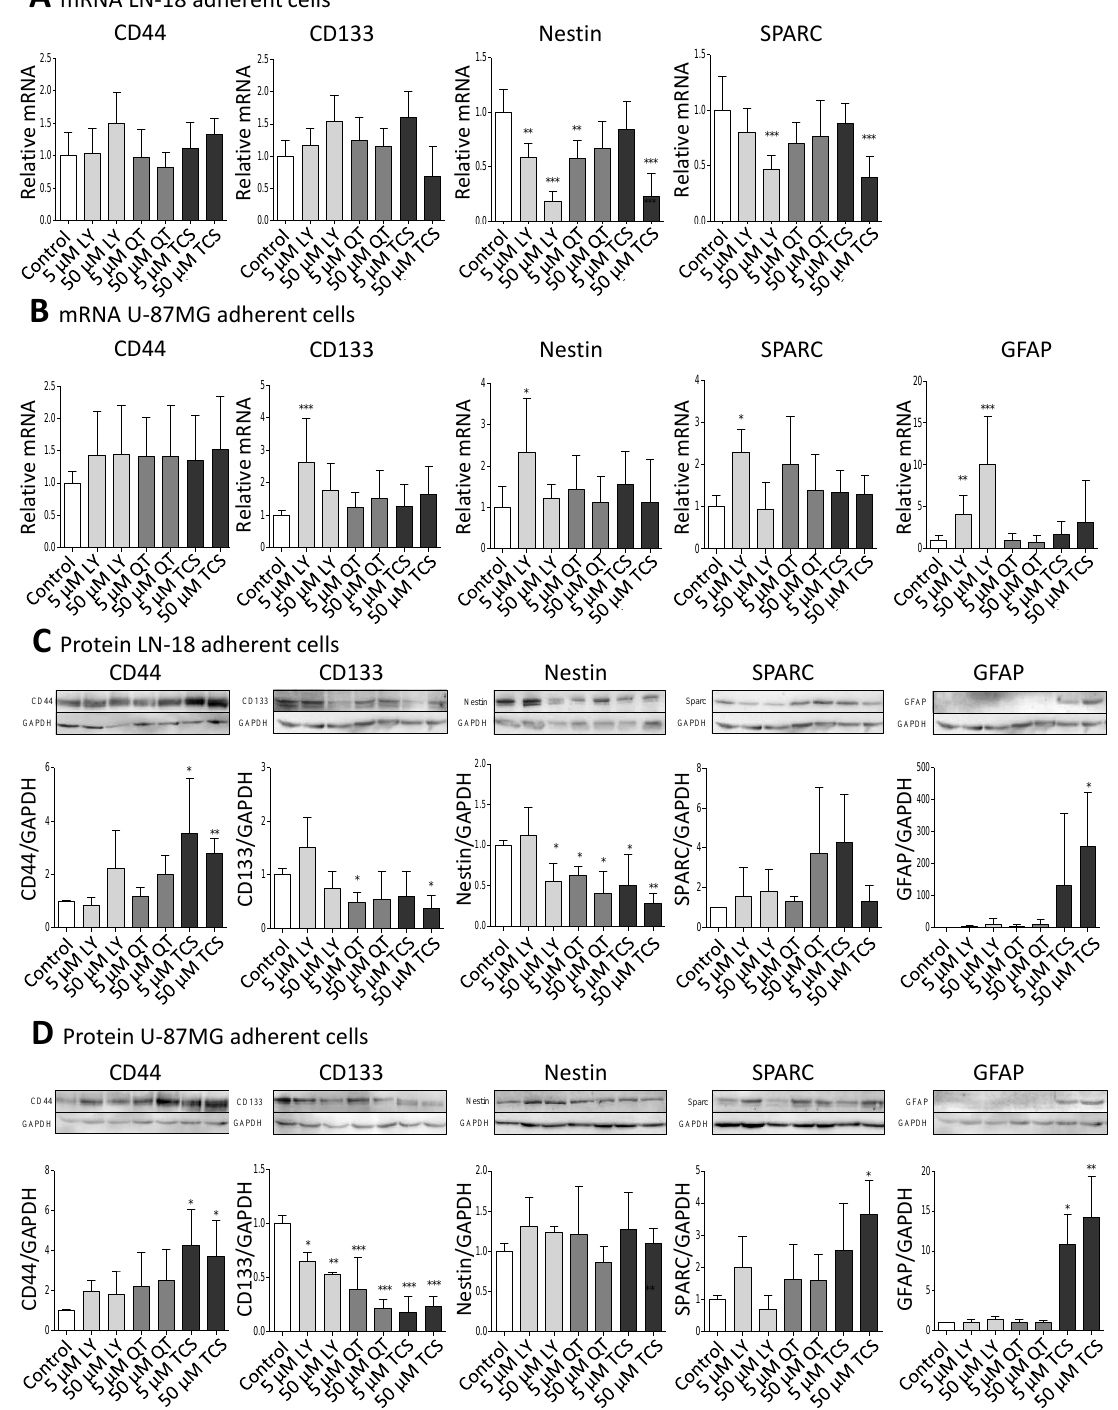
Figure 1. Pharmacological PIM1 blocking regulates expression of stemness and differentiation marker proteins in GBM cells. Human GBM cells (LN-18, U-87 MG) were treated each with 5 or 50 µM of the dual PI3K/PIM1 inhibitor LY294002 (LY), or the selective PIM1 inhibitors quercetagetin (QT) and TCS PIM1-1 (TCS). The respective solvent, dimethylsulfoxide